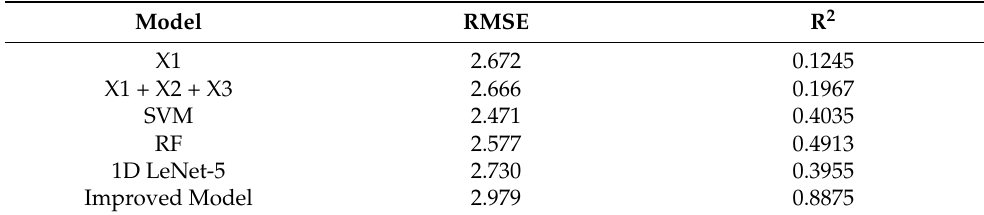
Table 3. Comparison of prediction effects of different models (X1 is B8 − B8a; X2 is the NDVI of B8a and B7; X3 is B5/B6; X4 is B4/B8a; X5 is the NDVI of B8a and B4, sorted by feature